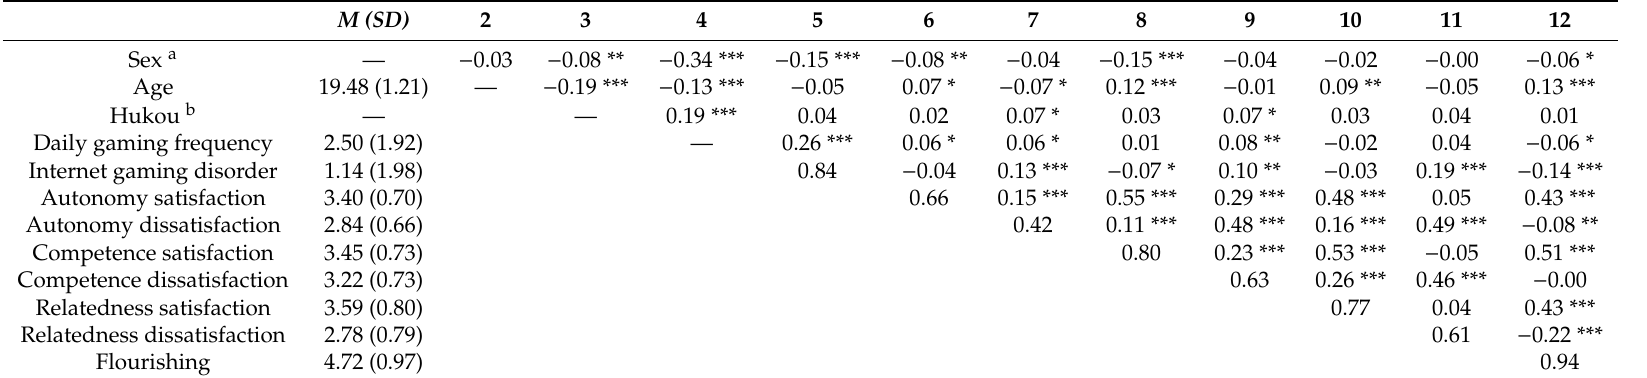
Table 1. Summary of Means, Standard Deviations, and Intercorrelations for the Measures ( N =